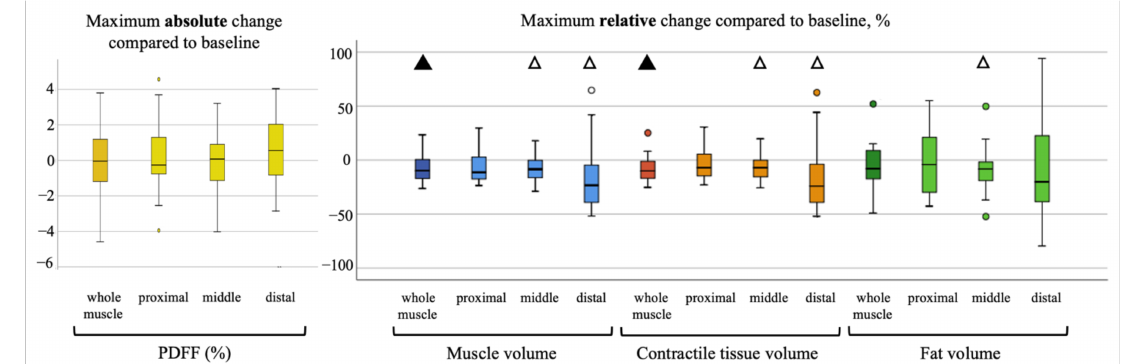
Figure 3. Visualization of absolute maximum change of M. psoas PDFF on the left, relative maximum change of muscle volume, contractile tissue volume and fat volume per proximal, middle and distal muscle section on the right. Statistical significance of change tested with one-sample t -test (compared to no change with test value = 0), (cid:52) = <0.05, (cid:78) = <0.01. No statistical significance of change differing between muscle sections (tested with one-way ANOVA analysis) was